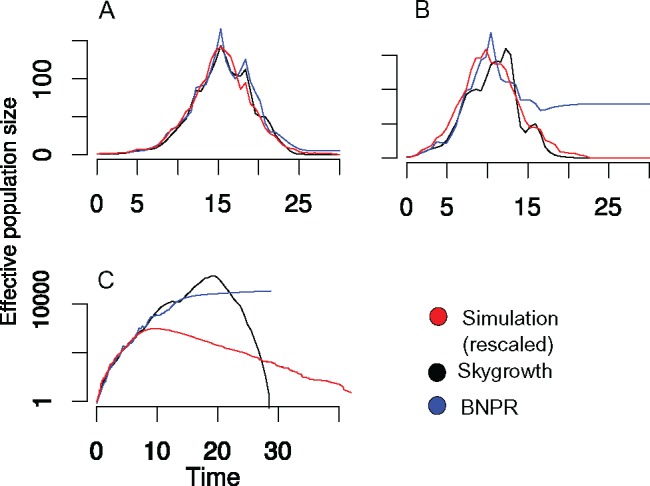
Comparison of effective population size estimates using the skygrowth and skygrid models applied to data from a susceptible-infected-recovered simulated epidemic. Effective population size estimates are also compared to the number of infected hosts through time under a linear rescaling (red). a) Estimates using a SIR model and simulated genealogy with 1000 sampled lineages and \documentclass[12pt]{minimal}
\usepackage{amsmath}
\usepackage{wasysym}
\usepackage{amsfonts}
\usepackage{amssymb}
\usepackage{amsbsy}
\usepackage{upgreek}
\usepackage{mathrsfs}
\setlength{\oddsidemargin}{-69pt}
\begin{document}
}{}$R_0=1.3$\end{document}. b) Estimates using a SIR model and simulated genealogy with 200 sampled lineages and \documentclass[12pt]{minimal}
\usepackage{amsmath}
\usepackage{wasysym}
\usepackage{amsfonts}
\usepackage{amssymb}
\usepackage{amsbsy}
\usepackage{upgreek}
\usepackage{mathrsfs}
\setlength{\oddsidemargin}{-69pt}
\begin{document}
}{}$R_0=1.3$\end{document}. c) Estimates using a SIR model and simulated genealogy with 200 sampled lineages and \documentclass[12pt]{minimal}
\usepackage{amsmath}
\usepackage{wasysym}
\usepackage{amsfonts}
\usepackage{amssymb}
\usepackage{amsbsy}
\usepackage{upgreek}
\usepackage{mathrsfs}
\setlength{\oddsidemargin}{-69pt}
\begin{document}
}{}$R_0=5$\end{document}.